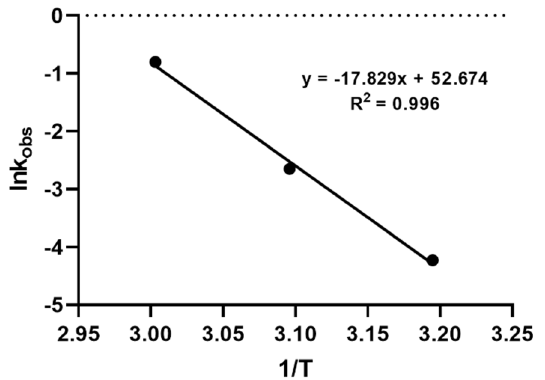
Figure 4. Arrhenius plot for CMS degradation in the presence of 0.5 M sulfuric acid at temperatures 40 °C, 50 °C, and 60 °C.